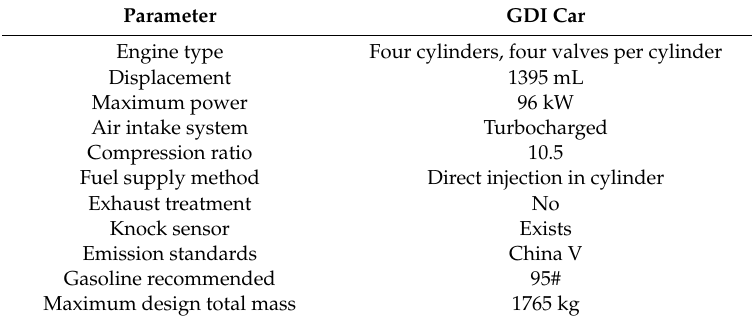
Table 1. Detailed engine parameters. GDI: gasoline direct